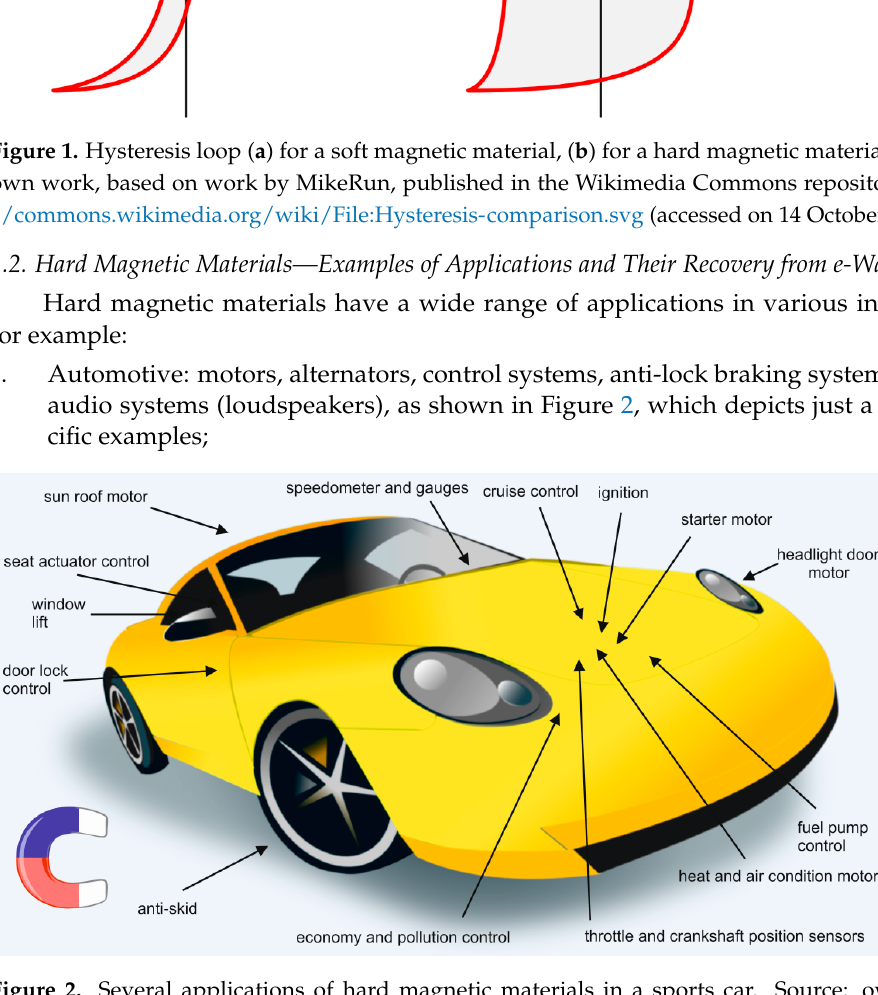
Figure 2. Several applications of hard magnetic materials in a sports car. Source: own work, based on the concept from [3]. Artwork from Public Domain Clip Art Image: Sports Car (http://www.publicdomainfiles.com/show_file.php?id=13525765816842 (accessed on 14 October 2022)) (2400 × 2171) (https://openclipart.org/detail/174368/magnet) (accessed on 14 October 2022).